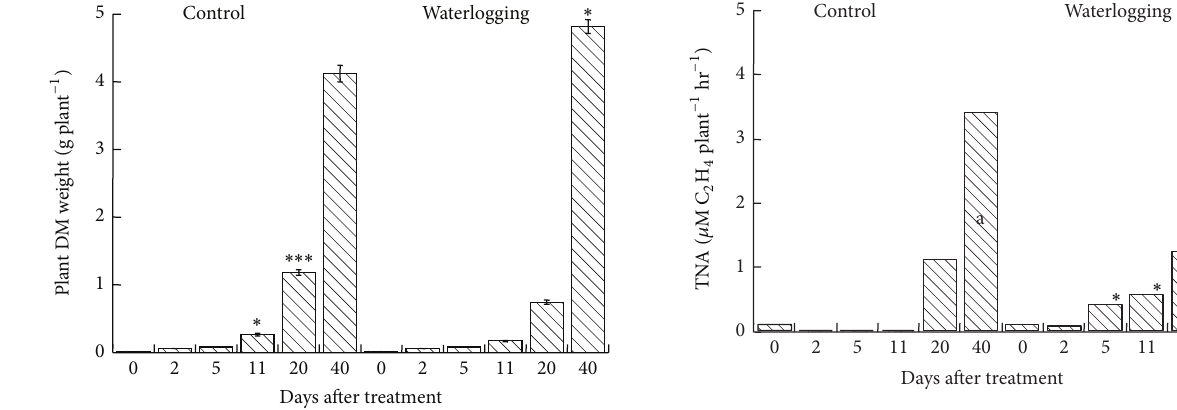
Figure 6: Changes in plant DM weight in experiments 2. ∗∗∗ and ∗ Significantly different ( 𝑃 < 0.001 and 𝑃 < 0.05 ) between control and waterlogging treatment at the same sampling day. Error bars give ± one SE ( 𝑛 = 3 ).